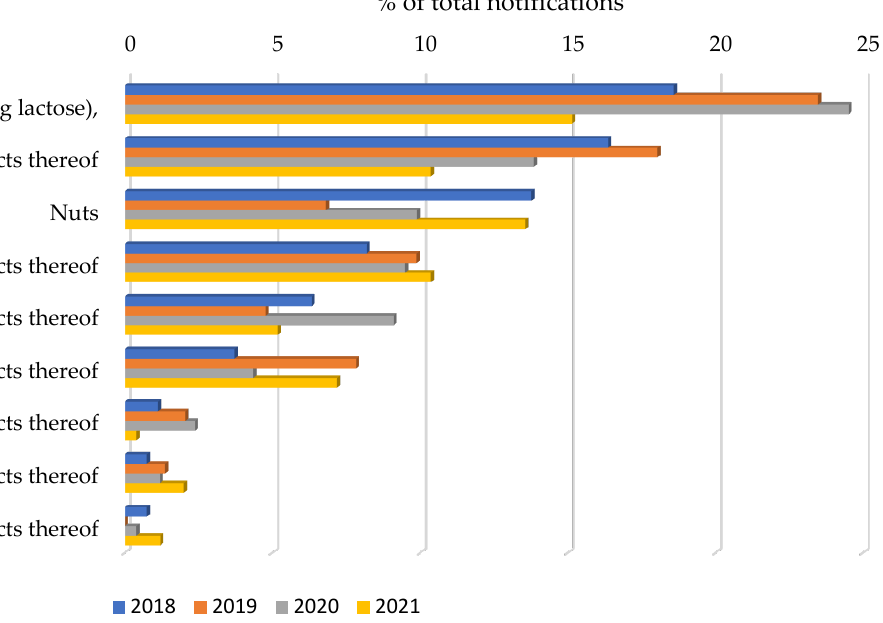
Figure 3. Percentage of total notifications of the main allergens affecting the pediatric population per year.